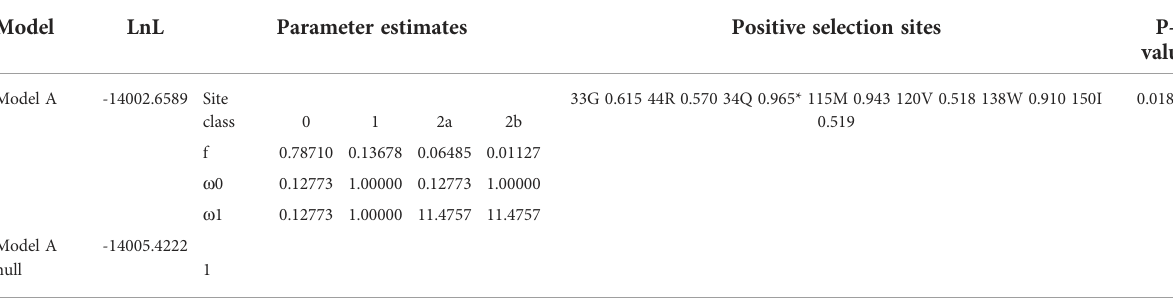
TABLE 3 Amino acid sites under positive selection shown in the Ⅱ clade, when Ⅰ and Ⅱ were set as background. Model